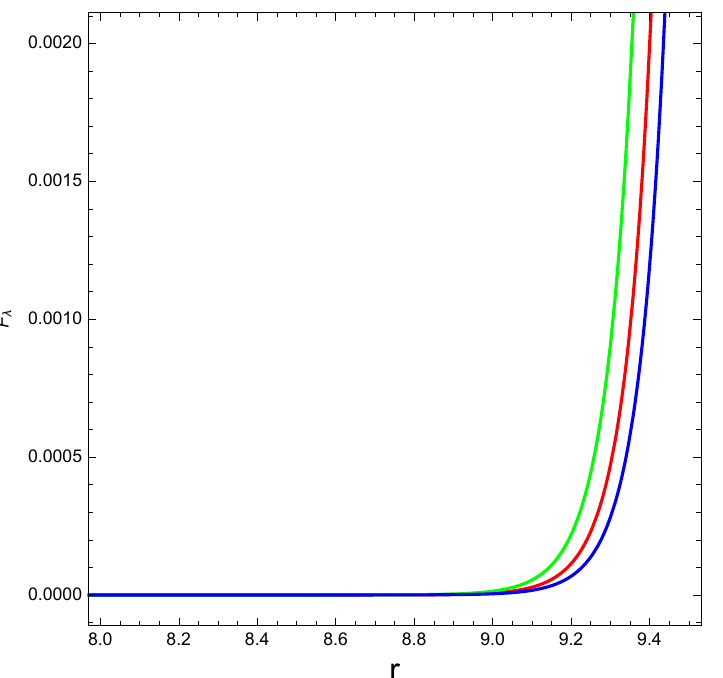
Figure 15. Solution of F ( R ( r )) for R adopted as a linear function of radius. The evolution of partial derivative of f ( R ) is obtained by comparing Equation (7) and Equation (33). We have fixed the values of η 2 , η 3 , a 0 , a 1 , a 2 , K , and C 1 . The red, green, and blue lines correspond to small perturbations of λ 0 , Ψ 0 , and η 1 , respectively.